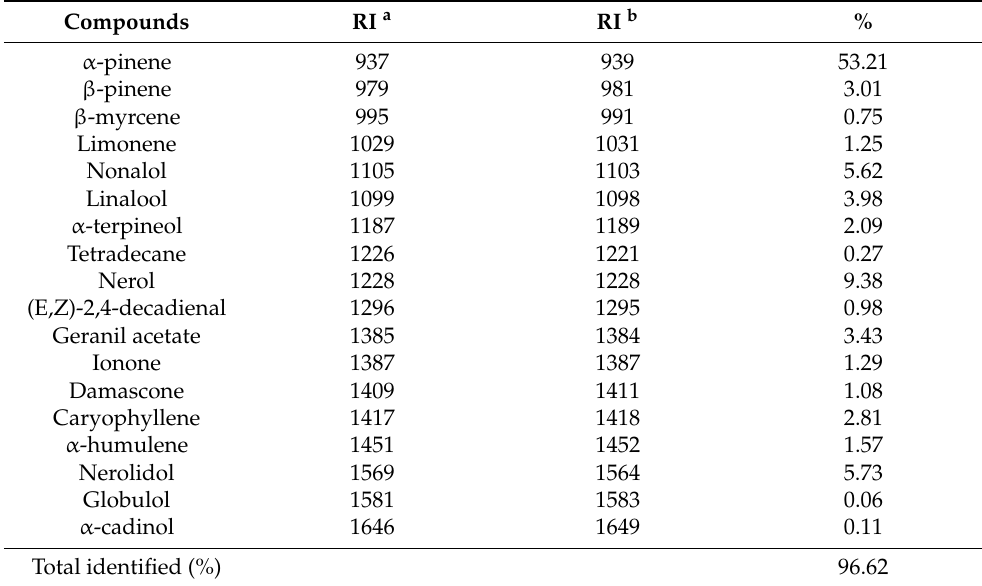
Table 1. Chemical composition of the essential oil from leaves of Syzygium cumini (L.) Skeels. Compounds